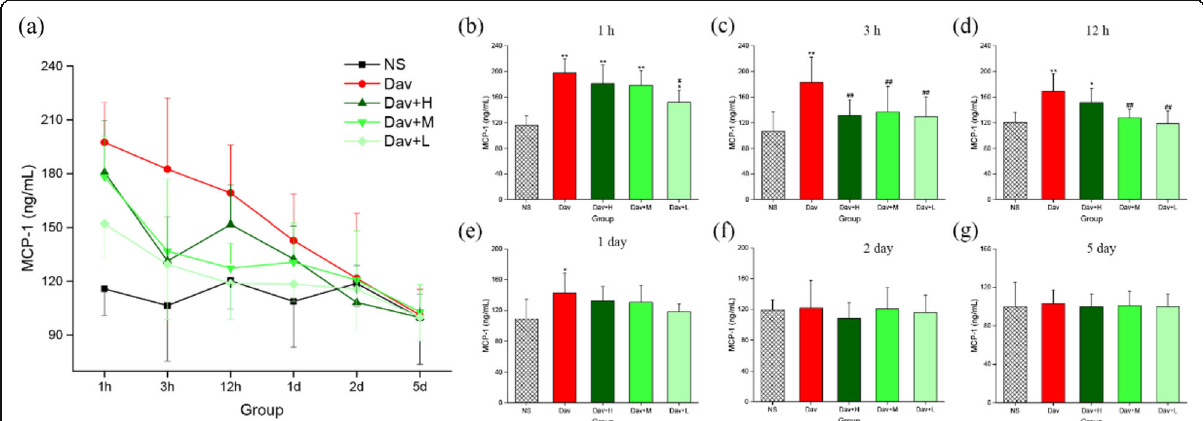
Fig. 9 Effects of Phellodendri Chinensis Cortex Carbonisata-carbon dots (PCCC-CDs) on the level of IL-10 in the kidney tissue. a IL-10 level changes in 1 h, 3 h, 12 h, 1 day, 2 days, and 5 days. The level of IL-10 in ( b ) 1 h, ( c ) 3 h, ( d ) 12 h, ( e ) 1 day, ( f ) 2 days and ( g ) 5 days. Mice were treated with normal saline (NS), D.acutus venom (Dav, 1 mg/kg) and high (H), medium (M), and low (L) doses of PCCC-CDs + Dav (1 mg/kg). Data are represented as mean ± SD of six animals of each group. * p < 0.05 and ** p < 0.01 compared with control group treated with normal saline (NS). # p < 0.05 compared with Dav group